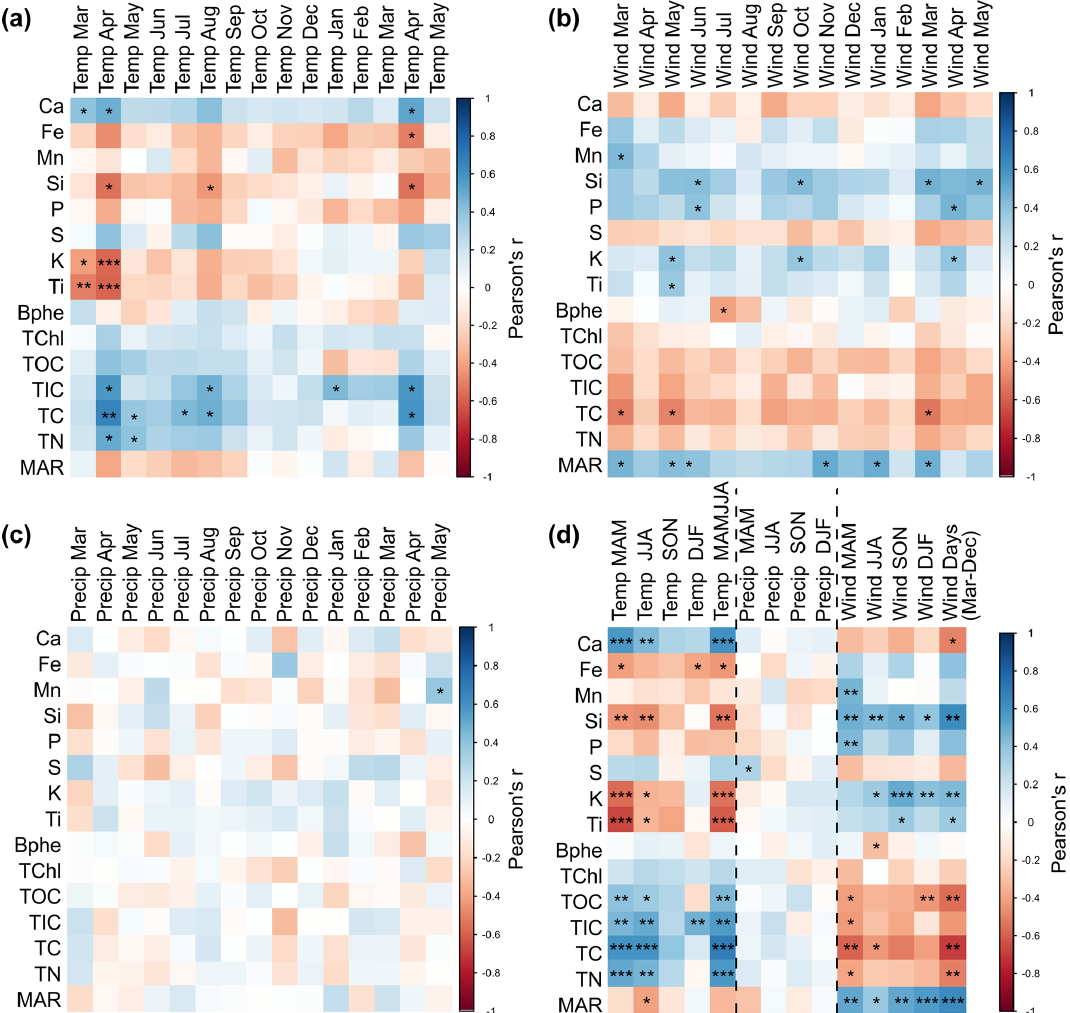
Figure 6. Correlation matrices of Pearson correlation coefficient ( r ) for sedimentary variables (annual mean values) and (a) mean monthly temperature, (b) 90th percentile of daily mean wind speeds for each month, (c) 90th percentile of daily precipitation for each month, and (d) seasonal versions of the aforementioned meteorological variables. Significance of correlations is identified by * symbols (* p adj < 0 . 1, ** p adj < 0 . 05, *** p adj < 0 . 01) where p values have been adjusted for autocorrelation (Bretherton et al., 1999) and false discovery rate (Benjamini and Hochberg,